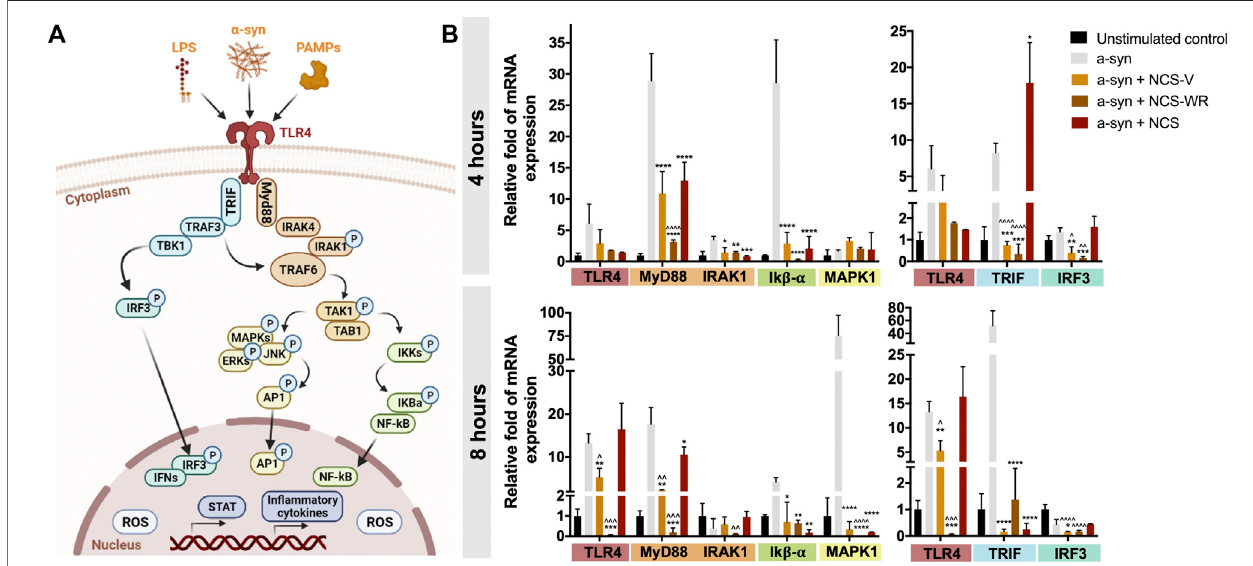
FIGURE5| TLR4-signalingmodulationbyNCSextractsin α -synucleinstimulatedmonocytes. (A) SchematicofthethreeprincipalsubpathwaystriggeredbyTLR4 activation. Ligand binding to TLR4 elicits two MyD88-dependent and one MyD88-independent responses, which result in the nuclear translocation of NF-kB, AP1 and IRF3. These three factors initiate in fl ammatory responses by promoting the transcription of in fl ammatory mediators and ROS production Created with BioRender.com. (B) RelativefoldofmRNAexpressionofsevenproteinsinvolvedinthethreesubpathwaysofTLR4signaling(e.g.,TLR4,MyD88,IRAK1,IkB- α ,MAPK1,TRIF,IRF3) after4and8 hof α -synucleinstimulationinthepresenceorabsenceofNCSextracts.Allextractsattenuatetheexpressionofthesein fl ammatorymarkers,withNCS-WR eliciting a superior effect. (*) denotes statistical signi fi cance with respect to the stimulated but untreated control, and ( ^ ) denotes signi fi cance with respect to traditional NCS. TLR4, Toll-like receptor 4; Myd88, myeloid differentiation primary response protein 88; IRAK1/4, IL-1 receptor-associated kinase 1/4; TRAF3/6, TNF receptor associated factor 3/6; TAK1, Transforming growth factor beta-activated kinase 1; TAB1, TAK1 Binding Protein 1; IKK, Inhibitor of Kappa B Kinase; IKB α , inhibitor of kappa B- α ; NF-kB, nuclear factor kappa B; MAPK, mitogen-activated protein kinase; JNK, c-Jun N-terminal kinases; ERK, extracellular signal-regulated kinase; AP1, activator protein 1; TRIF, TIR-domain-containing adaptor-inducing interferon- β ; TBK1, TRAF Family Member Associated NF-kB Activator-binding kinase 1; IRF3, interferon regulatory factor 3; IFN, interferon; STAT, Signal Transducer and Activator of Transcription.